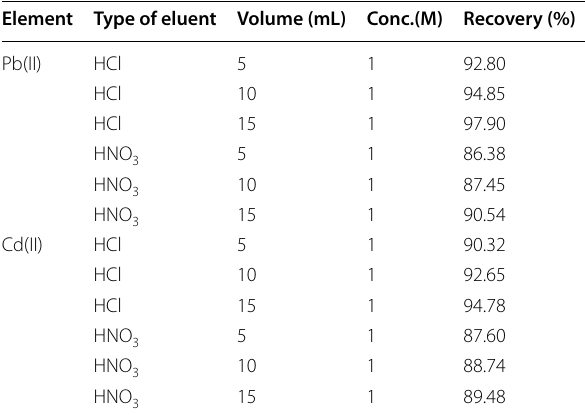
Table 1 Effect of the type and volume of elution solutions on the recovery of Pb(II) and Cd(II) Element Type of eluent Volume (mL) Conc.(M) Recovery